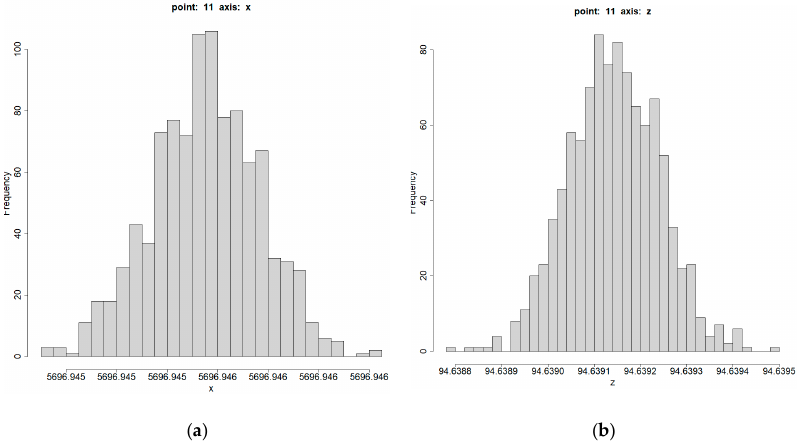
Figure 9. Histograms of the variations of ( a ) x- and ( b ) z-coordinates of station 11 after GUM and MC simulation.